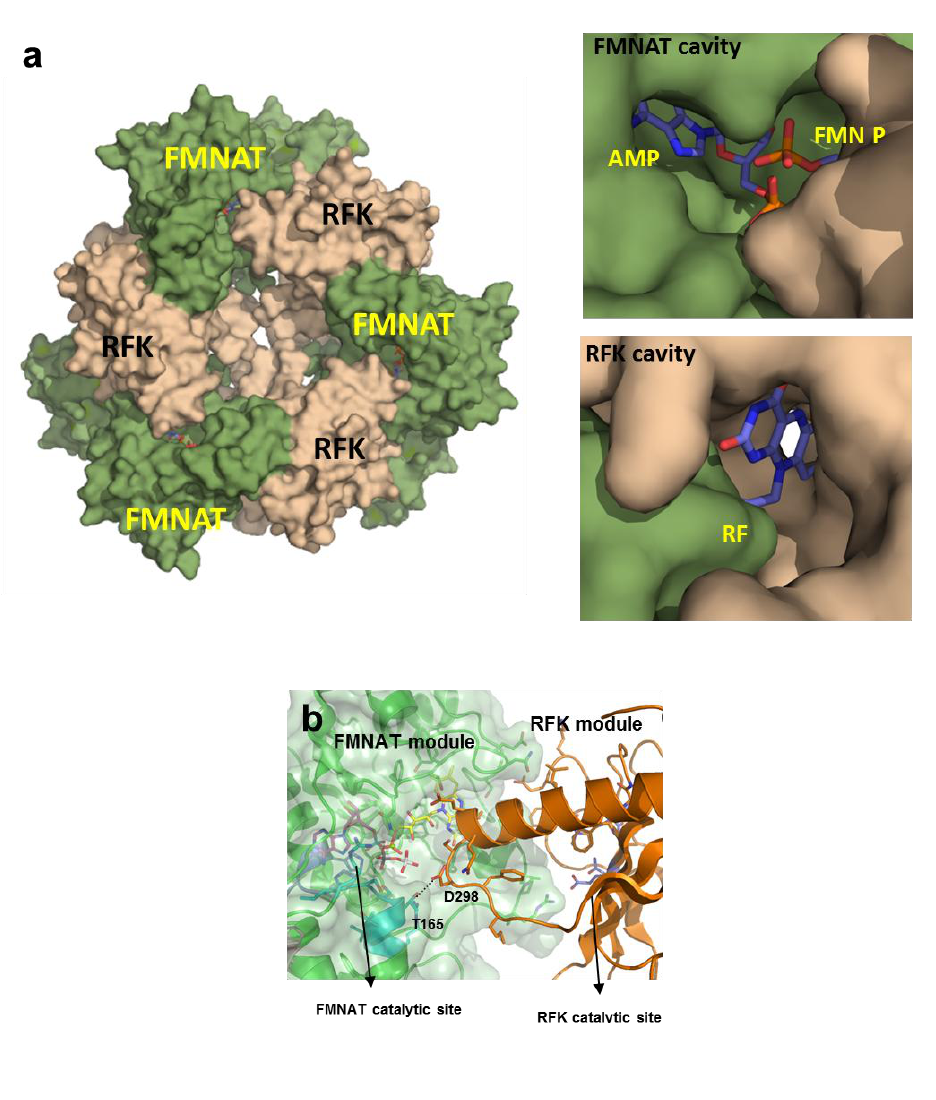
Figure S4. ( a ) Surface representation of the hexamer of Ca FADS and detail of the RFK and FMNAT cavities. The docked ligands are represented by sticks. ( b ) Detail of the contacts between RFK (in cartoon and orange) and the FMNAT (in surface and green) between two protomers in the trimeric structure of Ca